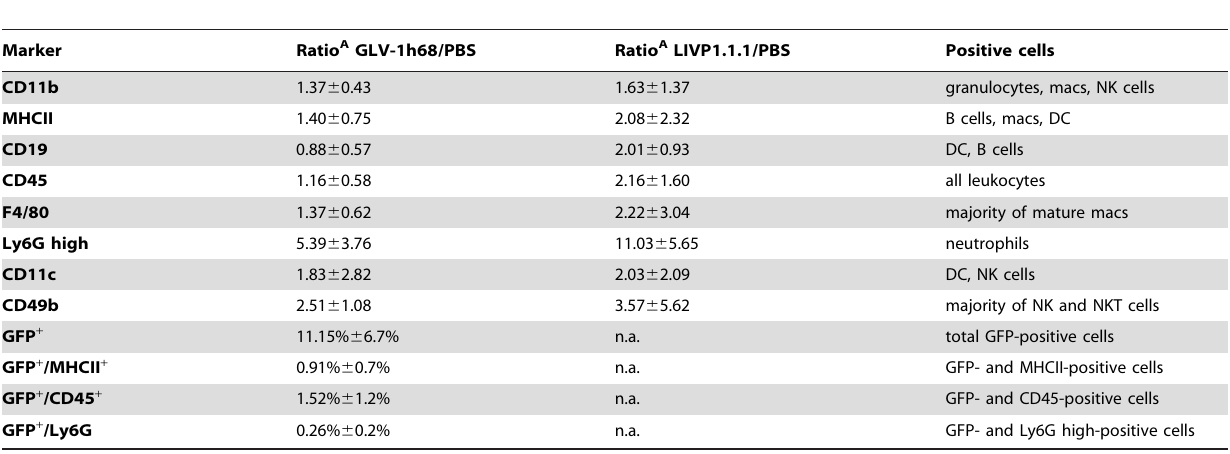
Table 2. FACS characterization and comparison of tumor single cell suspensions derived from infected and uninfected STSA-1 tumors at 7 dpvi (n=3)